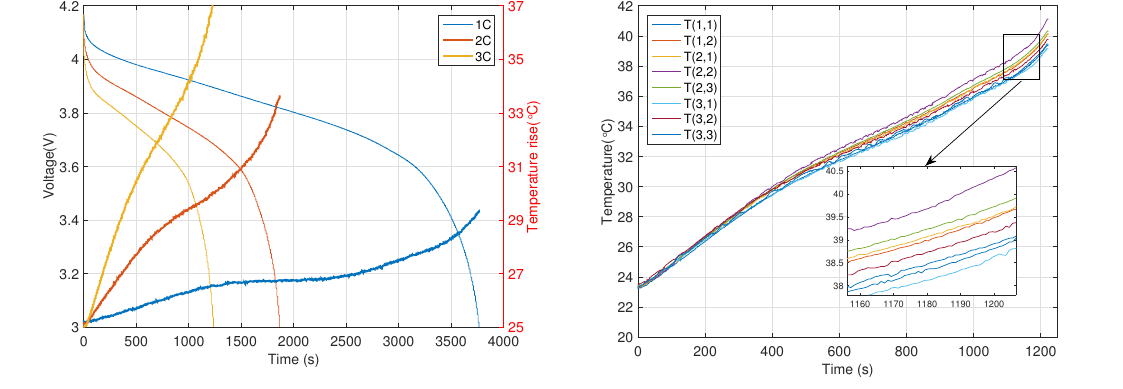
Figure 8. Voltage and temperature experimental